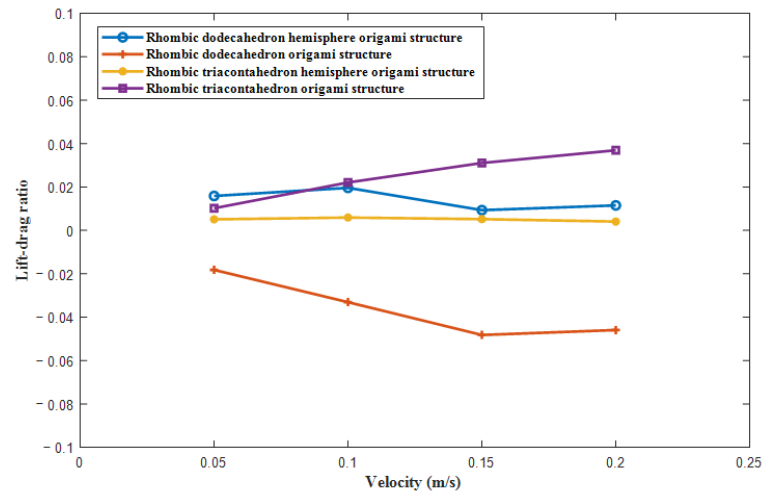
Figure 7. The relationship curve between the lift–drag ratio and the swimming speed under different origami structures.